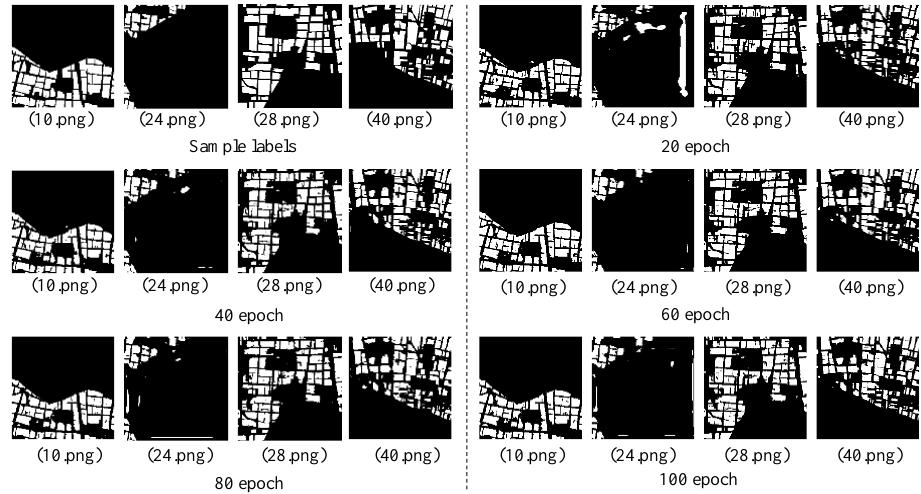
Figure 9. Visual comparison of extracted soybeans at different training epochs.